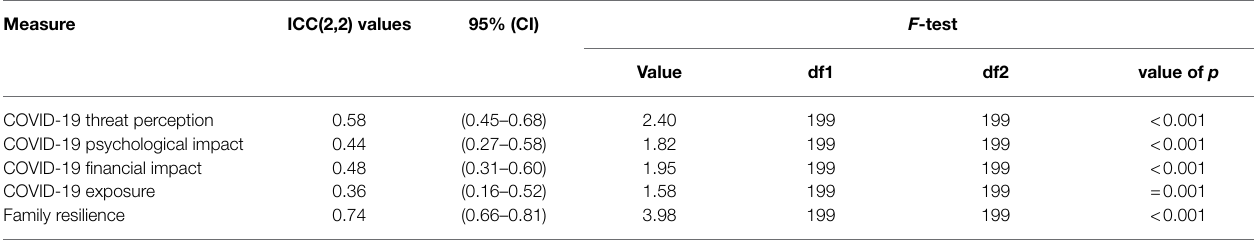
TABLE 2 | Intraclass correlations (ICC) for dyad